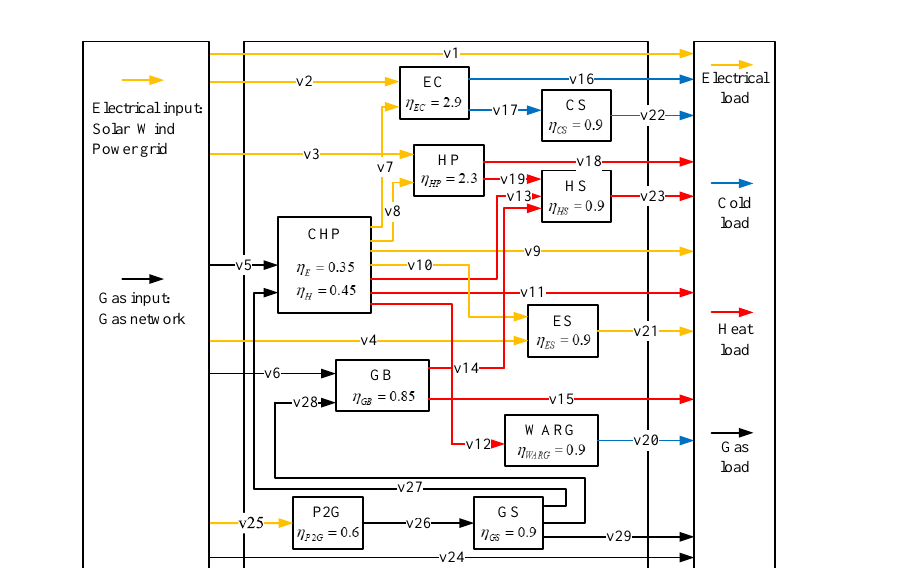
Figure 2. PIES 1 structure with P2G equipment.